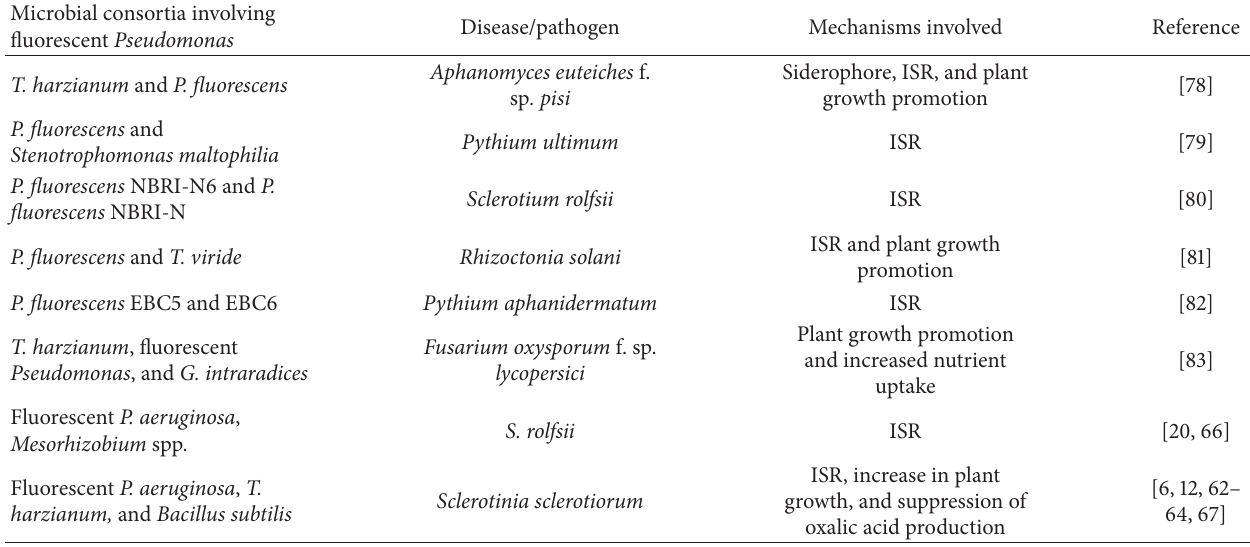
Table 1: Microbial consortia with fluorescent Pseudomonas as one of the components and mechanisms involved in disease suppression. Microbial consortia